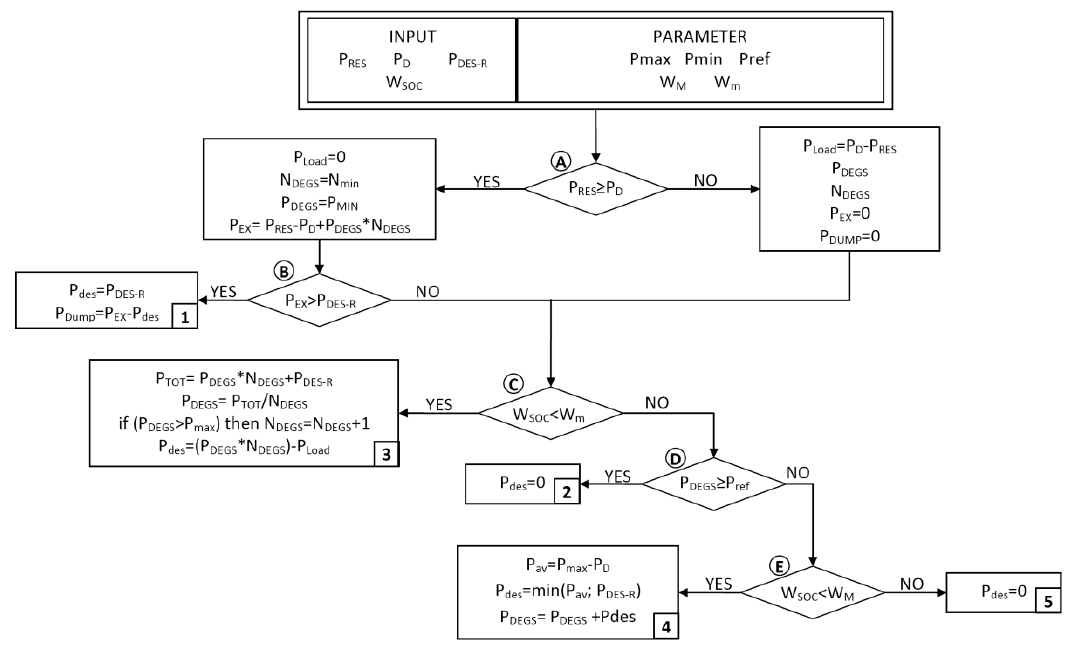
Figure 3. Energy/water control logic scheme.